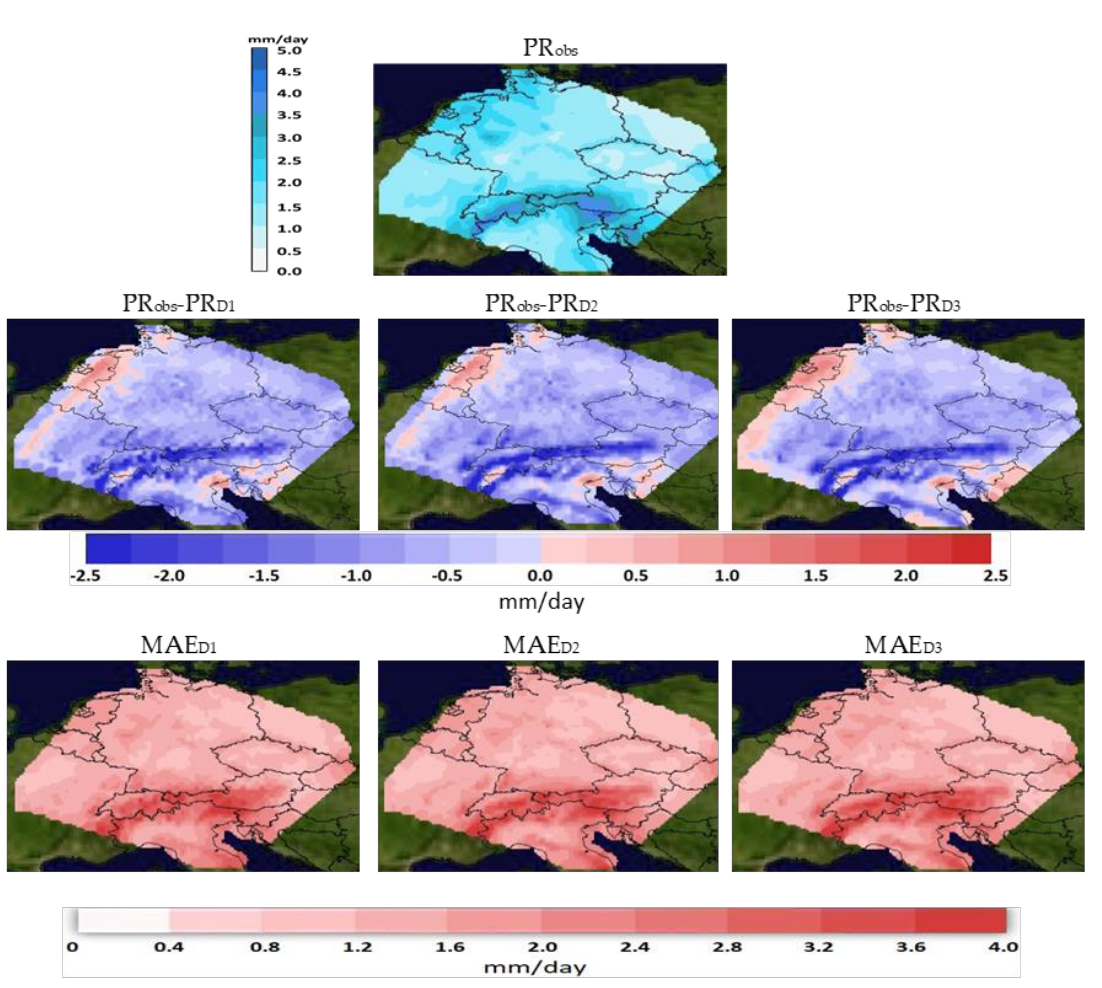
Figure 6. Spatial distribution plots for annual mean precipitation: observed data (upper panel), differences between observed and simulated data for the three nested domains (middle row), and the related MAE (lower row).